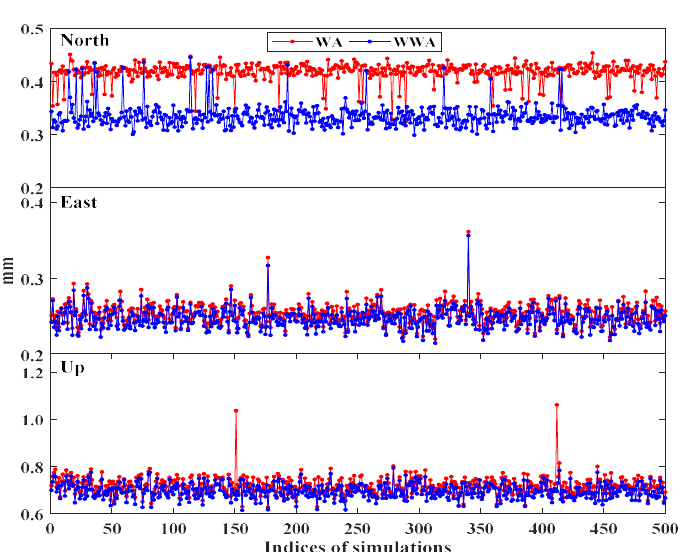
Table 2. Mean root mean square error (RMSE) and mean absolute error (MAE) of 500 simulations and improvement of WWA relative to WA.